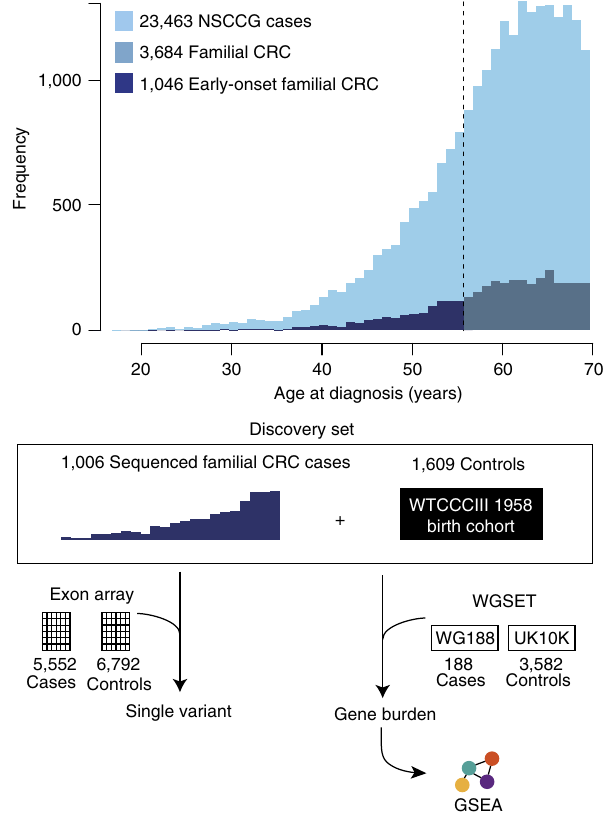
Figure 1 | Study design to investigate the contribution of rare disruptive mutations to the heritable risk of CRC. WES was performed on a highly enriched subset of CRC patients recruited to the NSCCG and a series of UK population controls from the 1958 Birth Cohort. After QC, this Discovery set comprised 1,006 early-onset (diagnosed r 55 years) familial cases ( Z 1 first-degree relative with CRC) and 1,609 controls. To test the hypothesis that low-frequency variants confer risk for CRC, we performed a meta-analysis alongside 12,344 UK samples genotyped on the Illumina HumanExome-12v1_A Beadchip. To test the hypothesis that a burden of rare mutations in a gene confers risk for CRC, we performed a burden test on rare ( o 1% frequency) coding variants and subsequent meta-analysis alongside additional sequencing data from 3,770 UK samples (WGSET). Finally, we performed GSEA to investigate whether the burden of rare variants are overrepresented in a specific biological